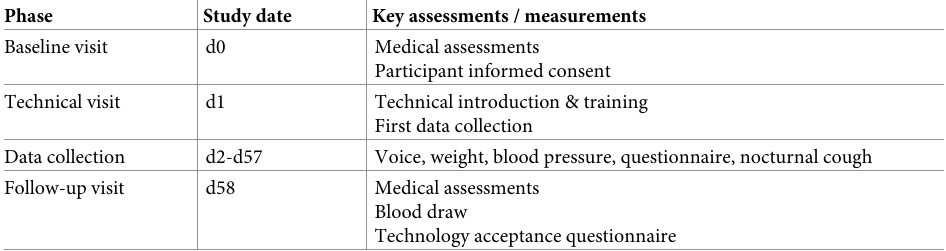
Table 2. Assessments and measurements through the study period.